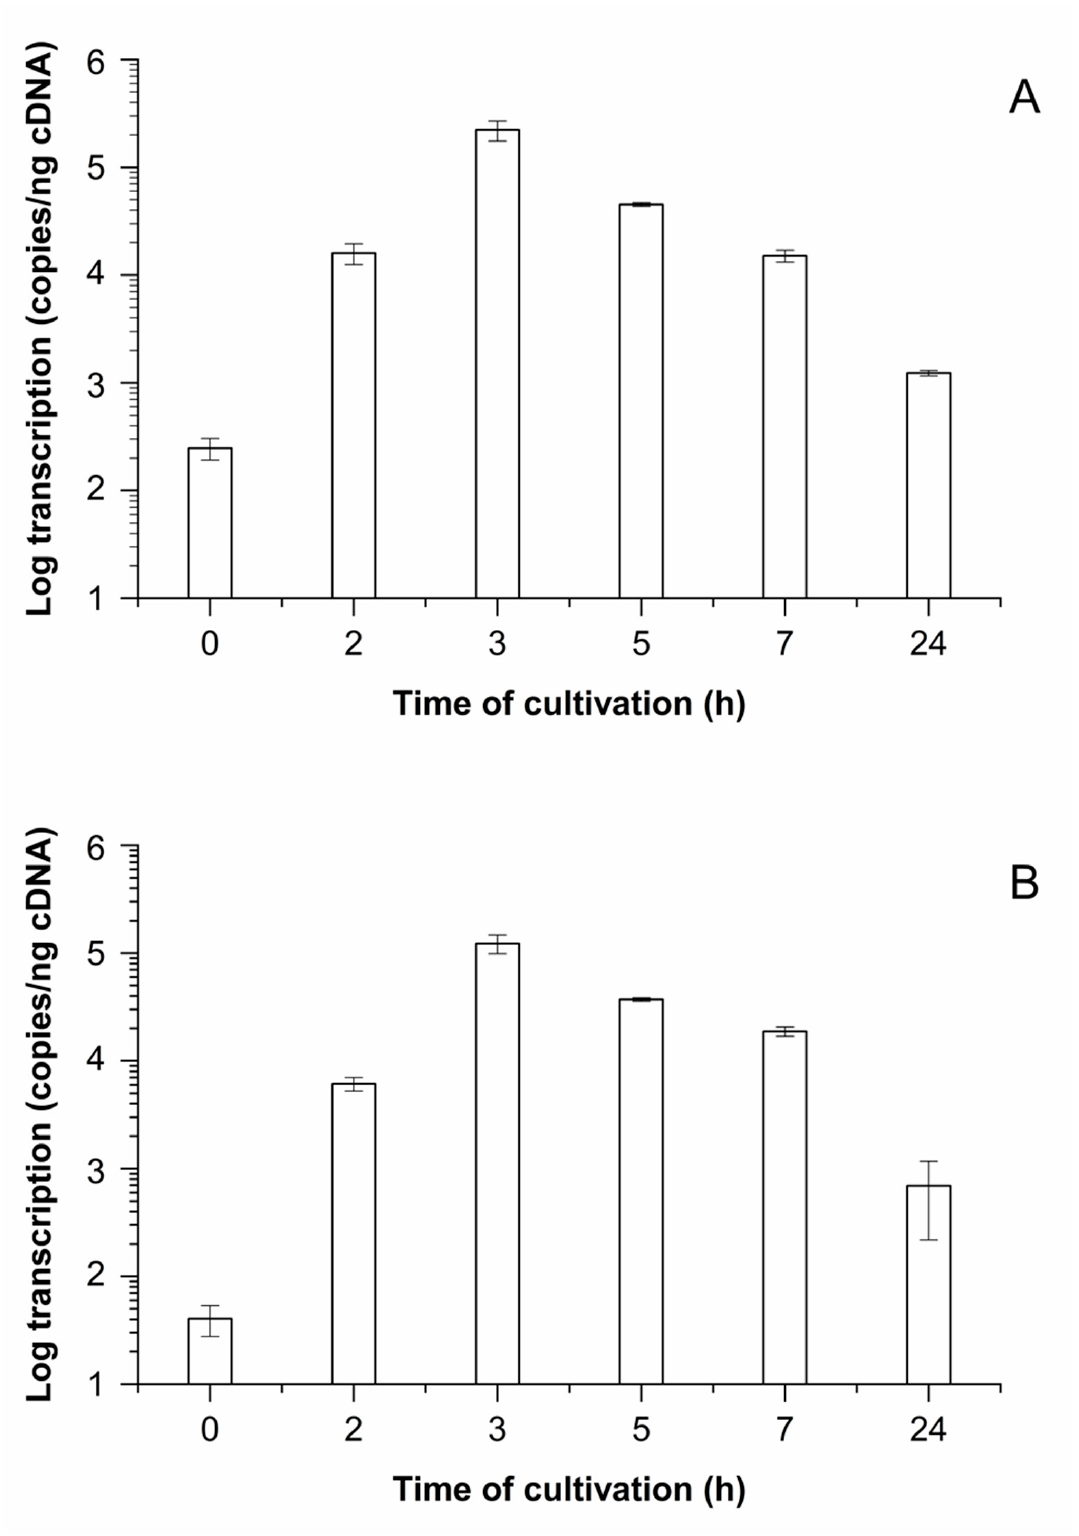
Figure 3. prtP transcription of strains L. lactis LTH 7122 ( A ) and LTH 7123 ( B ) during growth in basic MCB (pH 6.6). Cultivation was carried out for 24 h, and samples were collected at the respective time points. The mean values and standard deviations of three biological and two technical replicates each are shown.